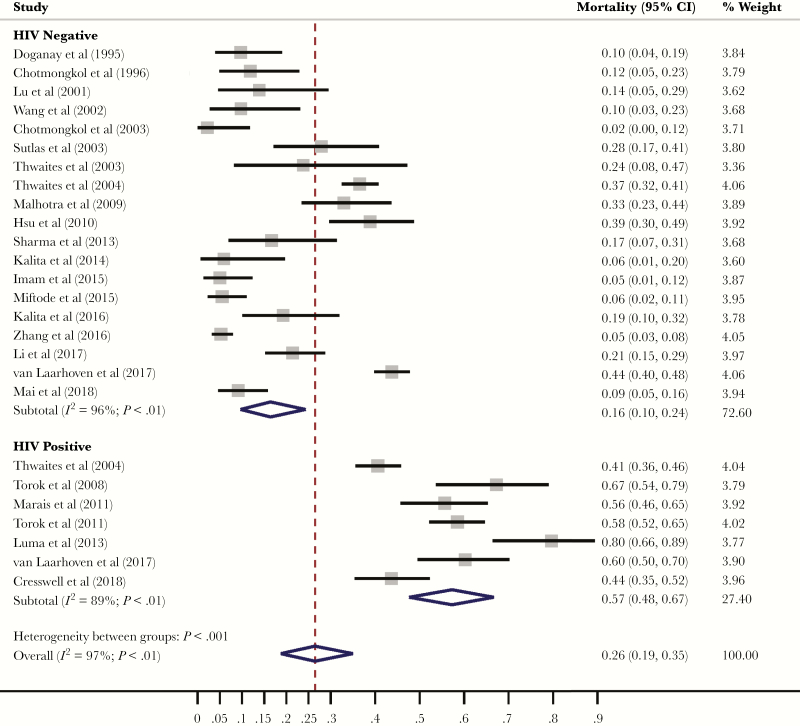
Tuberculous meningitis mortality by HIV status. Forest plot depicting mortality due to tuberculous meningitis stratified by HIV status. HIV status explains a significant amount of the heterogeneity in tuberculous meningitis mortality (P < .01).